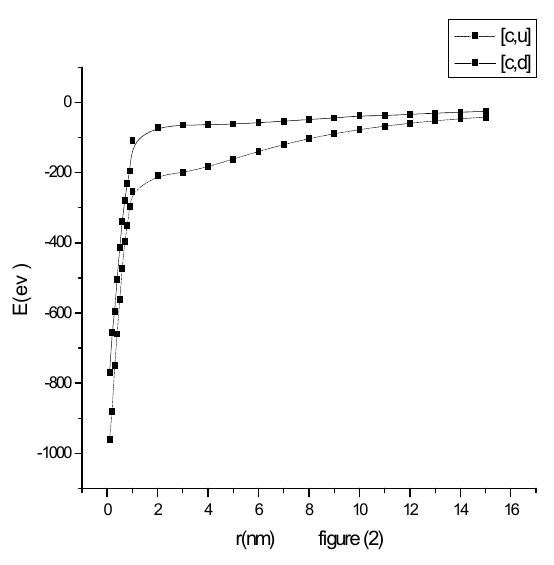
Fig. 2. Variation of Binding Energy with r_cutoff Variation R_cutoff is assigned the values between 0.1 and 1 fm. stands for strong interaction constant at high energies [24]. Based on the suitable